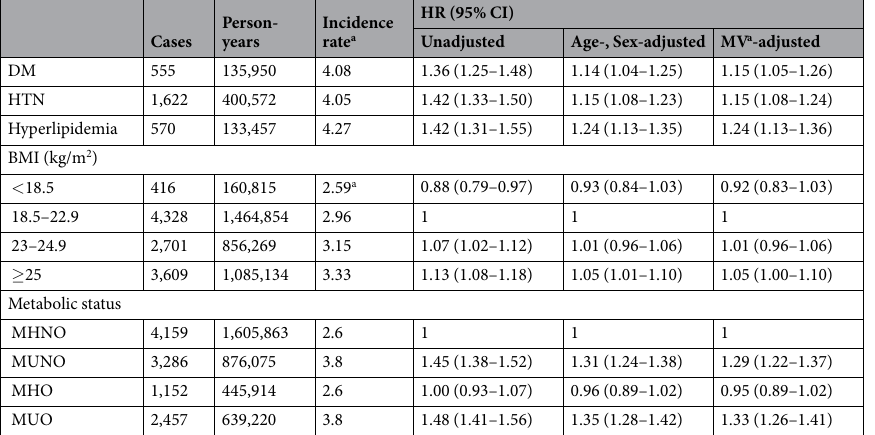
Table 2. Longitudinal association between metabolic parameters and incident psoriasis. a per 1000 person- years. HR, hazard ratio; CI, confidence interval; DM, diabetes mellitus; HTN, hypertension; BMI, body mass index; MHNO, metabolically healthy, non-obese; MUNO, metabolically unhealthy, non-obese; MHO, metabolically healthy, obese; MUO, metabolically unhealthy, obese. a MV includes age, sex, smoking, alcohol drinking, exercise, and income.